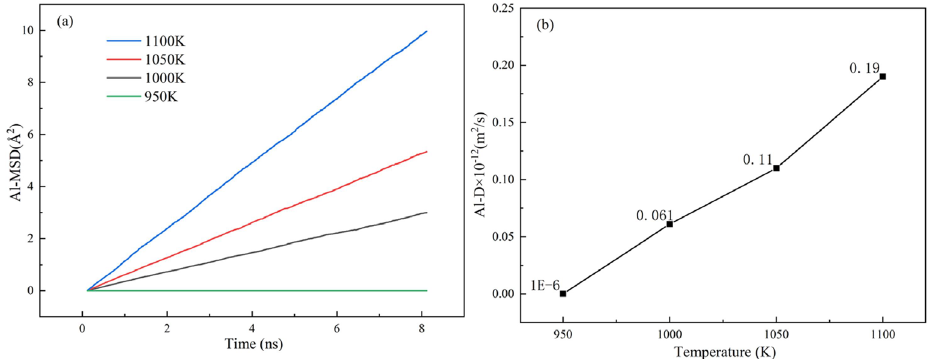
Figure 7. Diffusion of Al atoms at different temperatures: ( a ) MSD at different temperatures ( b ) Diffusion coefficient at different temperatures.